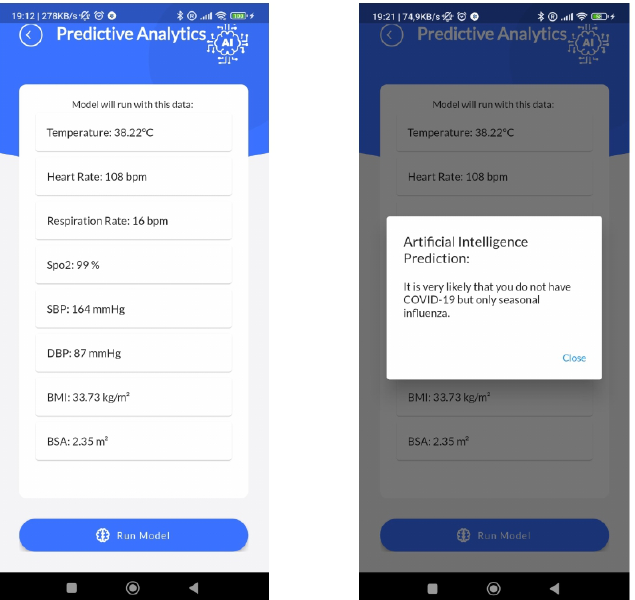
Figure 6. (ME) 2 app AI predictive analytics section; in particular, the AI model used to determine the difference between influenza vs. COVID-19 symptoms is